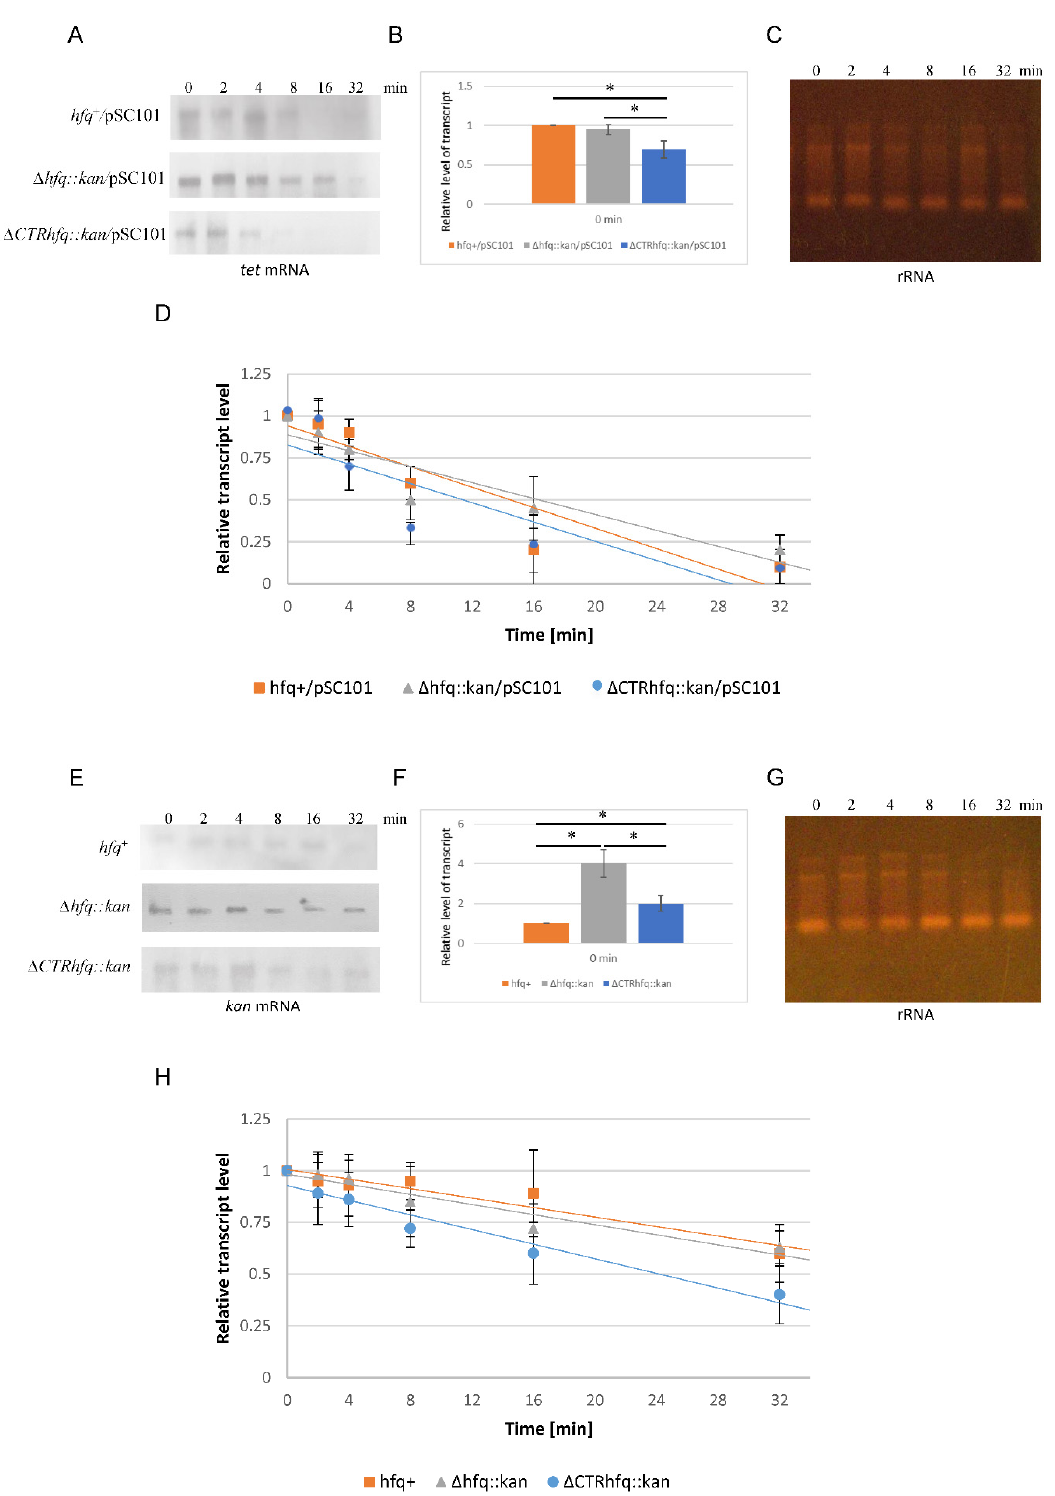
Figure 10. Levels and stability of tet ( A – D ) and kan ( E – H ) mRNAs in E. coli strains hfq + , ∆ hfq :: kan , and ∆ CTR hfq :: kan bearing either pSC101 ( A – D ) or no plasmid ( E – H ), as estimated by Northern-blotting. Representative blots ( A , E ) and quantification of results ( B , D , F , H ) are presented. Levels of mRNAs were calculated relative to internal controls—rRNA levels (representative of ethidium bromide-stained gels) are shown in panels ( C , G ). Values presented in panels ( B , D , F , H ) are mean values from three independent experiments with error bars showing SD. Statistically significant differences ( p < 0.05) between results presented in panels ( B , F ) are marked by